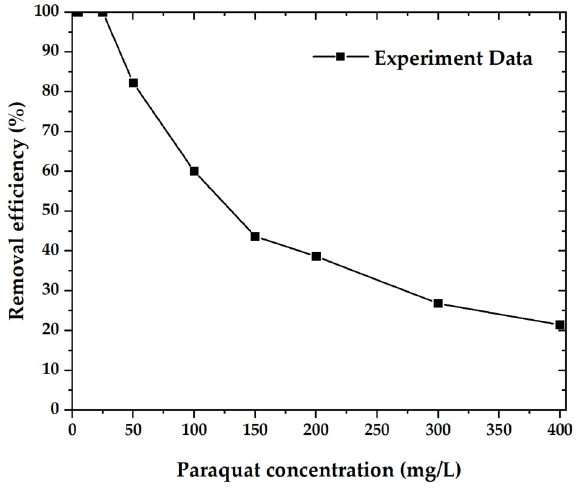
Figure 9. The removal efficiency of the material with paraquat.